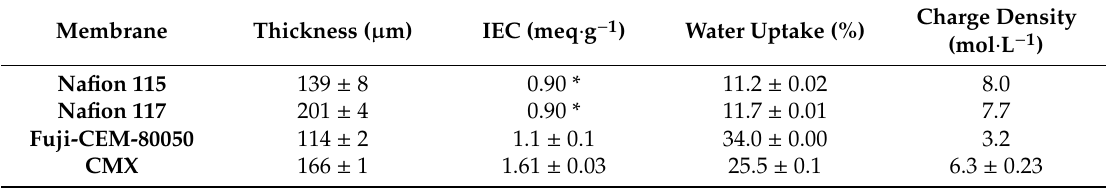
Table 2. Relevant physical and electrochemical properties of membranes at 25 ◦